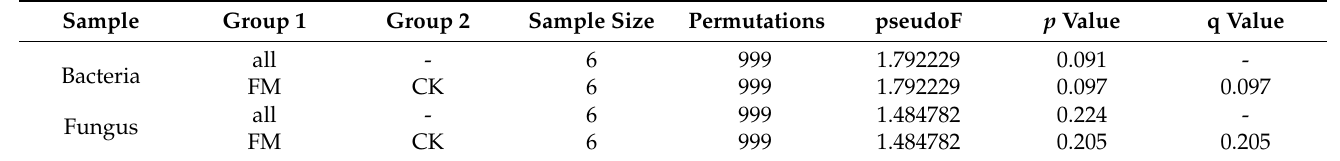
Table A1. Statistical table of difference analysis between groups.